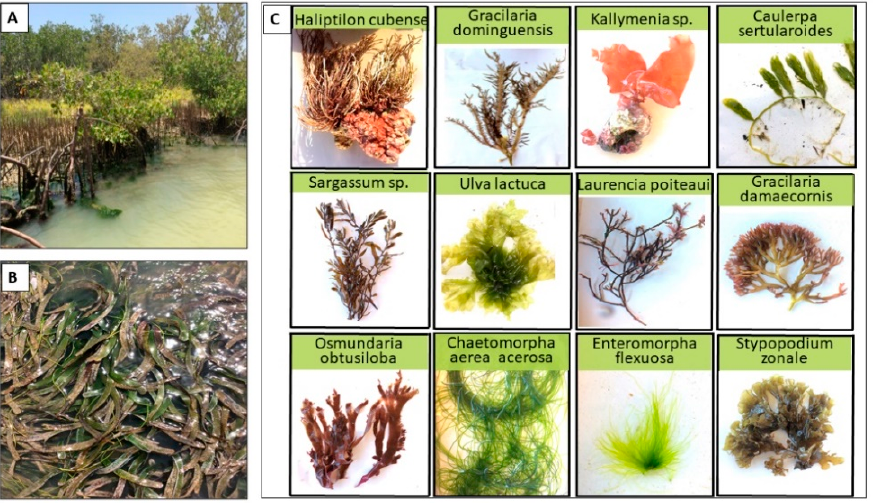
Figure 4. Examples of the diversity of marine plants of coastal eastern Guajira. ( A ): Mangrove trees Rhizophora mangle and Avicennia germinans ; ( B ): Seagrasses Thalassia testudinum and Syringodium filiforme ; ( C ): Macroalgae, including three species of red algae Gracilaria.